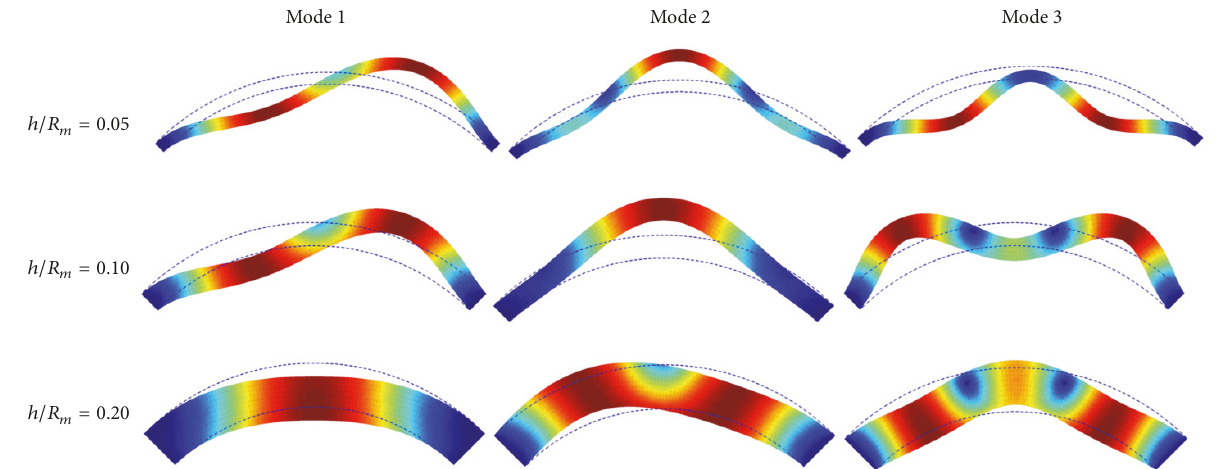
Figure 8: Modal shapes relative to the C-C circular curved beams of Table